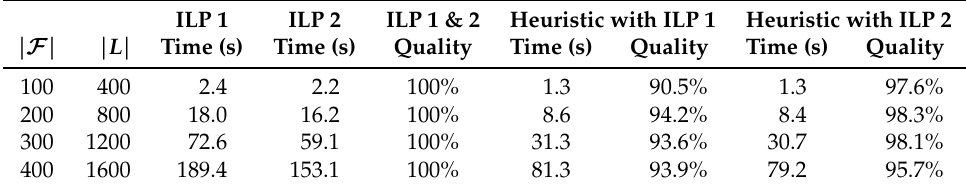
Table 4. Experimental results with the same setting as in Table 3, except that this time every square of size 2 × 2 was required to intersect at most two